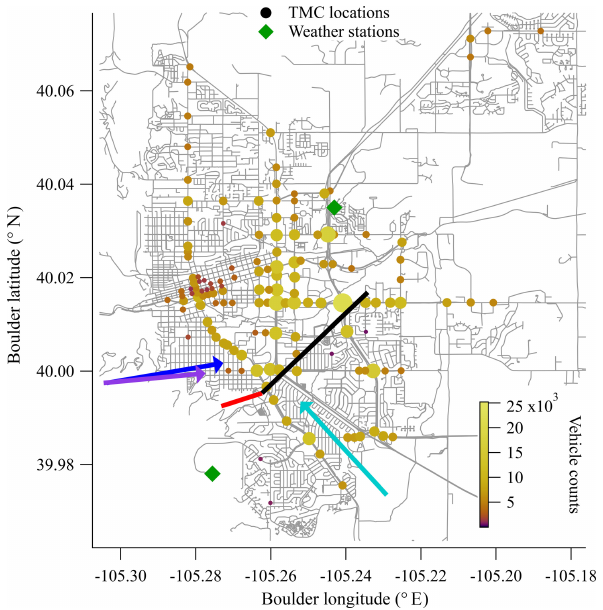
Figure 1. Measurement layout. The two measurement paths are shown by red (reference) and black (over-city) lines. The two weather stations that provided wind speed and direction data are given by the green diamonds. The colored circles are turning move- ment count (TMC) locations, which are used as a proxy for the traf- fic source locations. Both color and size represent the number of traffic counts at each location. Dominant wind directions for the campaign overall (aqua) and the test case days (purple for 22 Octo- ber and blue for 25 October) are given by colored arrows.